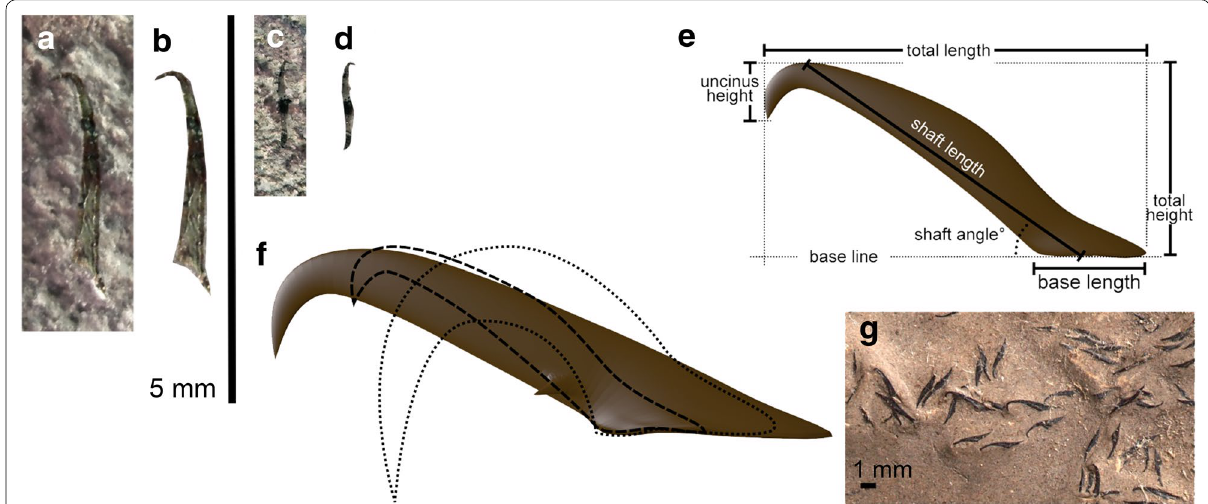
Fig. 5 Belemnoid arm hooks from the Late Cretaceous of Greece and comparative morphology. a – f SGL1_22a, b, Maastrichtian; large vertical scale bar refers to a to d . a The larger arm hook on SGL1_22a. b Cut out from photo in a to better show the outline. c Second specimen from SGL1_22a. d Cut out from photo in c to better show the outline. e Reconstruction of second specimen ( c , d ) with terminology and measurements. f Comparison of various arm hooks: Paraglycerites sp. (Jurassic; brown shaded), “ Striatuncus ” cretacicus (Maastrichtian; dotted outline), and specimen SGL1_22a, b (Maastrichtian; dashed outline). g Belemnoteuthis antiqua (Callovian)